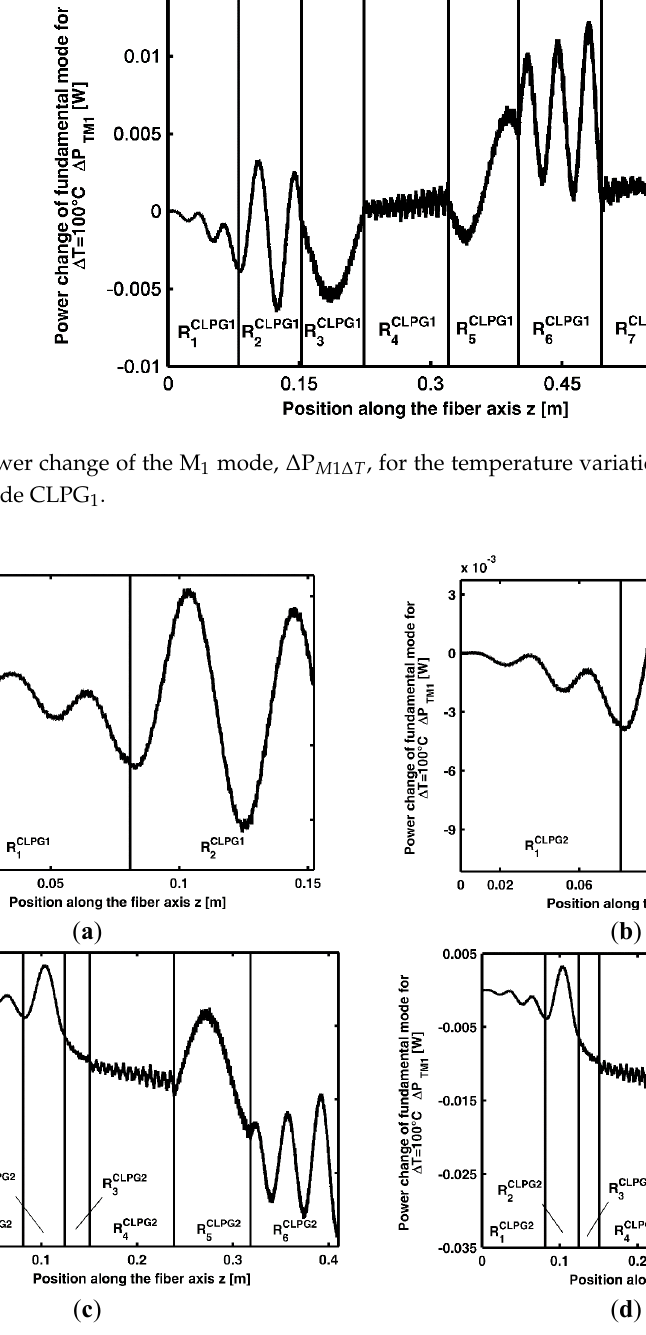
Figure 8. Power change of the M 1 mode, Δ P M1 Δ T , for the temperature variation 0–100 °C ( a ) along the grating cascade made of the first two gratings of CLPG 1 ; ( b ) along the grating cascade made of the first two optimized gratings of CLPG 2 and the third grating of CLPG 1 ; ( c ) along the grating cascade CLPG 2 ; ( d ) along the cascade made of the six gratings of Table 6 and the seventh grating of CLPG 1